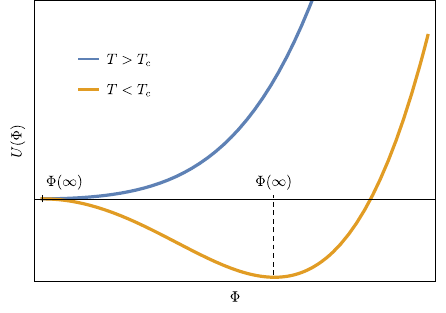
Figure 1 . Pro(cid:12)le of the e(cid:11)ective potential U ((cid:8)) at r = 1 , for T > T c and T < T c , as a function of (cid:8). The minimum of the e(cid:11)ective potential corresponds to (cid:8)( 1 ). For T > T c , the only possible minimum is the trivial one (cid:8)( 1 ) = 0.